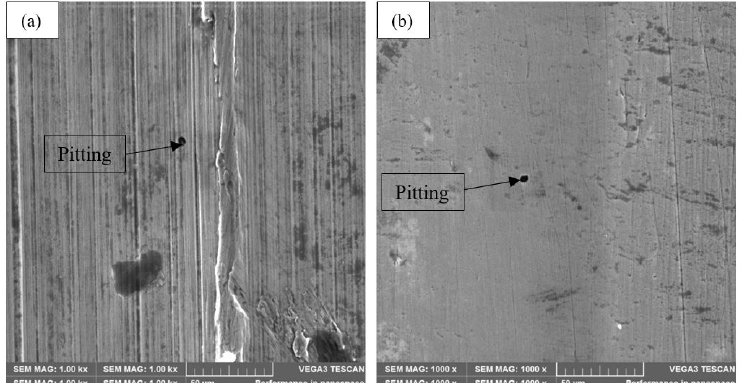
Figure 18. Samples of tests 3 (a) and 3P (b) with 1000X magnification.